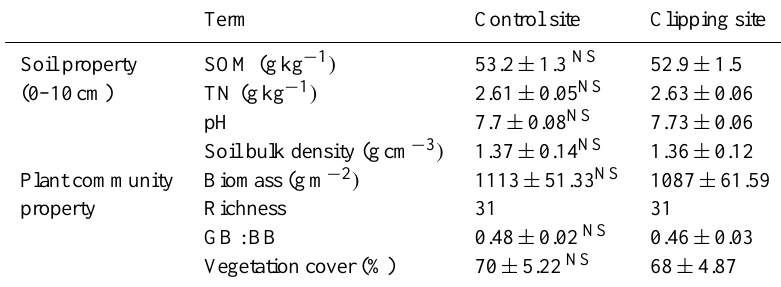
Table 1. Soil and plant community properties (mean ± SE) of control and clipping sites before